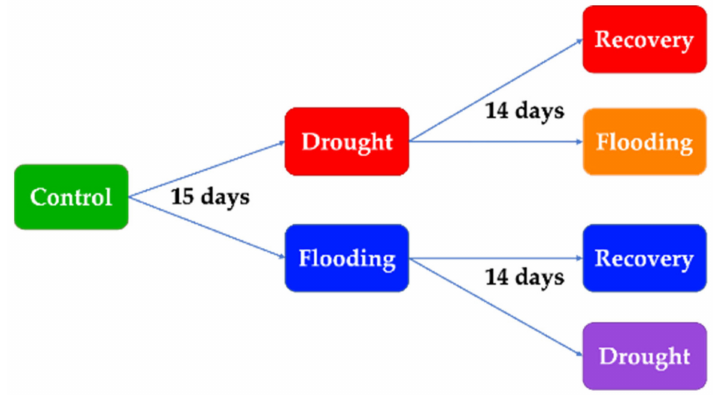
Figure 1. The design of the experimental